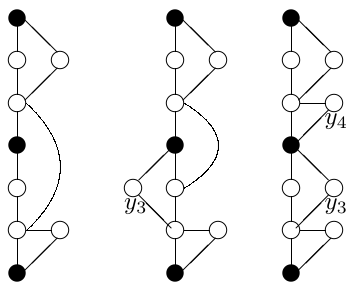
Fig. 20: Fixing v 5 for a maximum backbone tree of type 1 in case [2 . 1] .